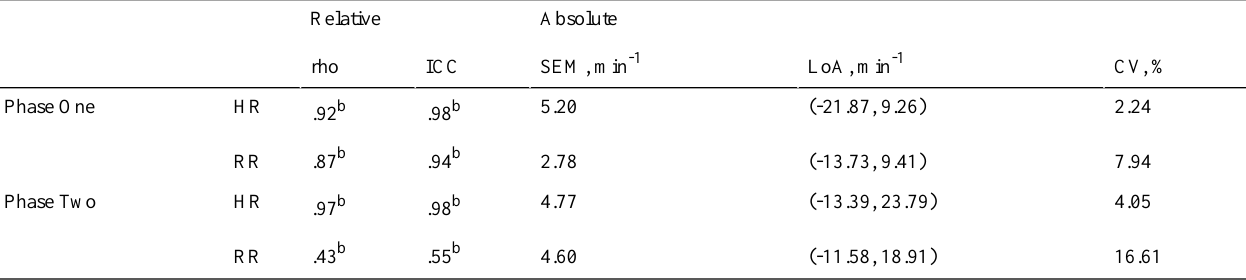
Table 4. Relative and absolute reliability of BioHarness heart rate and respiratory rate measures a .